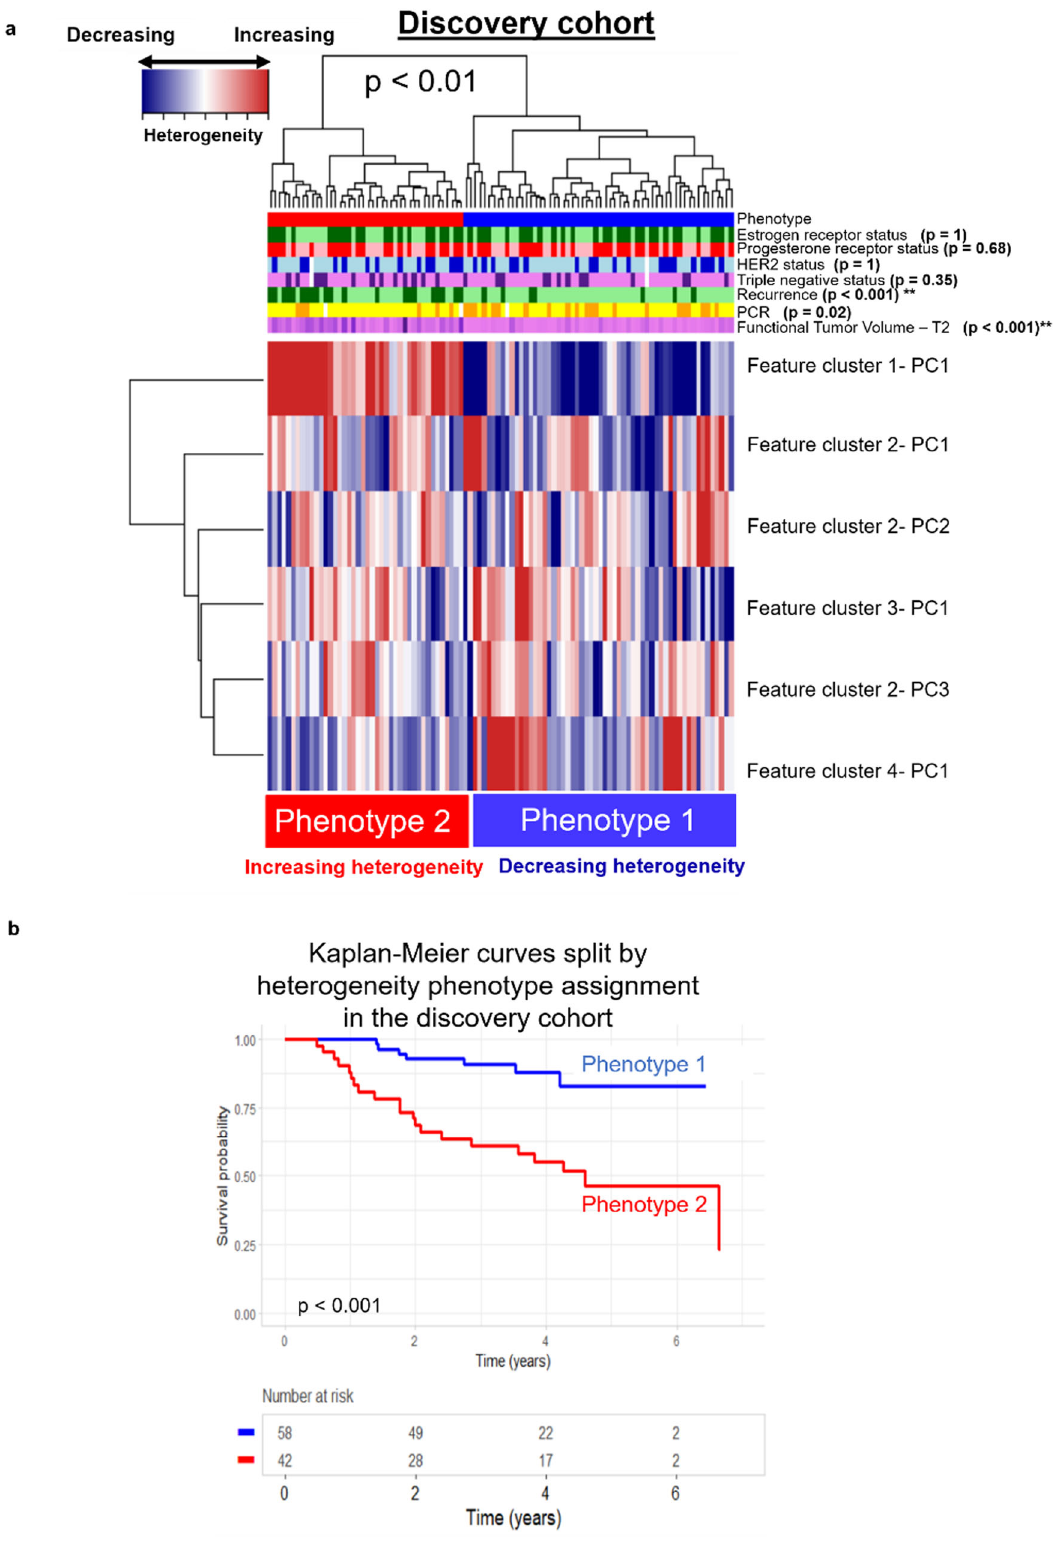
Fig. 1 Unsupervised Hierarchical Clustering of Tumors in the Discovery Cohort. a Unsupervised hierarchical clustering of tumors in the discovery cohort ( n = 100) identi fi ed two phenotypes of early changes in intratumor heterogeneity: decreasing heterogeneity from T1 to T2 (Phenotype 1, in blue) and increasing heterogeneity from T1 to T2 (Phenotype 2, in red). b Kaplan-Meier curves for recurrence free survival (RFS) of patient groups split by phenotype show signi fi cant separation, with tumors showing increase in intratumor heterogeneity after initiation of neoadjuvant therapy (Phenotype 2) having worse recurrence